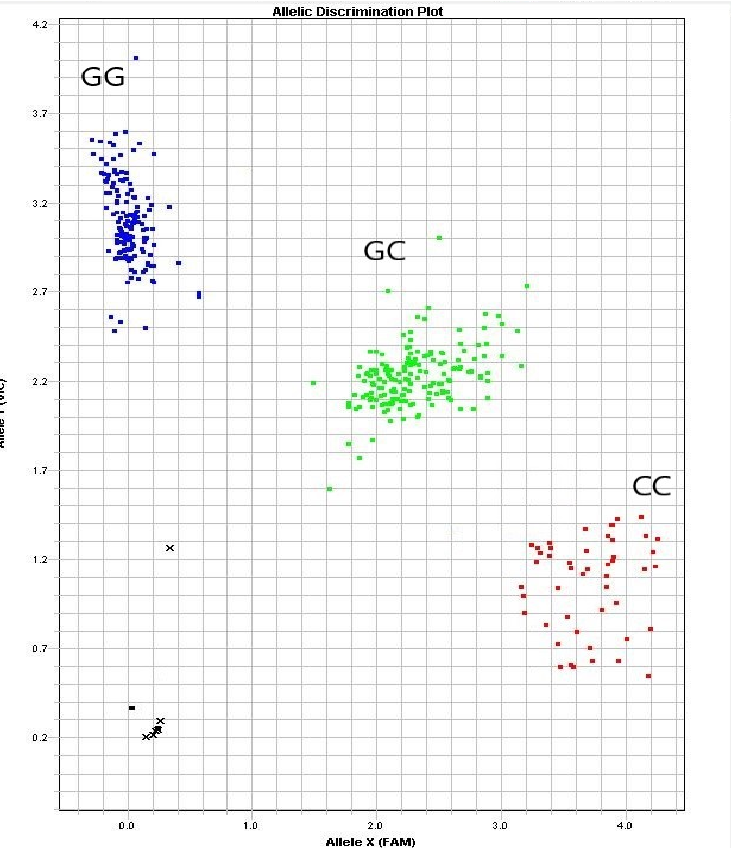
Figure 2. Discriminant map of the three clusters of alleles of the RBP4 g.36491960G>C mutation. Table 4. Population polymorphism analysis of loci in goats.